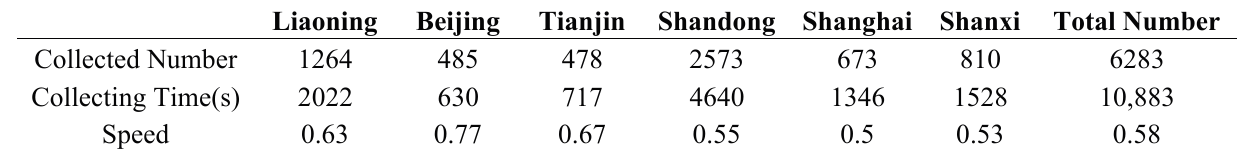
Table 2. Collection results and efficiency of the proposed deep web